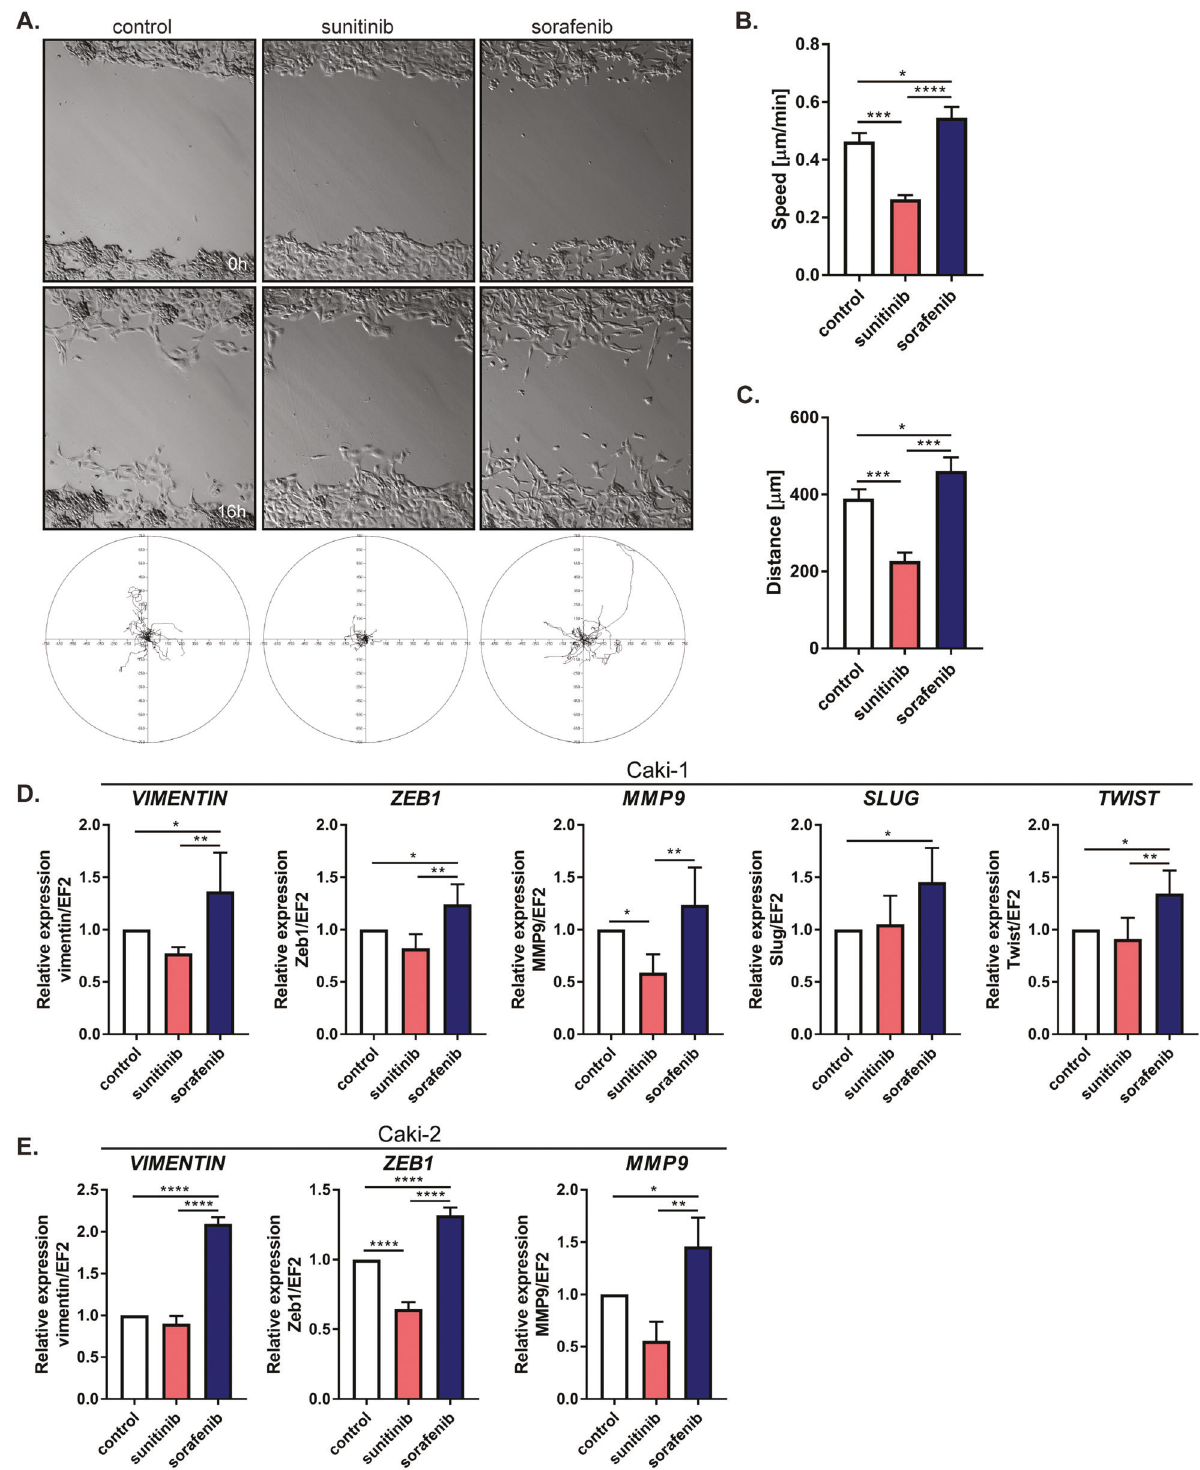
Fig. 2 Effect of sorafenib on EMT. A Representative images after 0 and 16 h (upper panel) of migratory paths during a 16-h time-lapse recording, N = 18 cells for each treatment (lower panel). B Quanti fi cation of the distance traveled by Caki-1 cells during the 16-h experiment. C Quanti fi cation of the speed of Caki-1 cells during the 16-h experiment. The results are presented as the mean ± SD of three independent experiments, with the number of cells analyzed for each cell line, N = 55. D mRNA level of EMT markers in Caki-1 cells after 24 h treatment with drugs, quanti fi ed with real-time PCR. E mRNA level of EMT markers in Caki-2 cells after 24 h treatment with drugs, quanti fi ed with real-time PCR. The results are presented as the mean ± SD of three independent experiments. P values were estimated using One-way ANOVA with post hoc Tukey ’ s multiple comparison test. * P < 0.05; ** P < 0.01; *** P < 0.001; **** P < 0.0001.